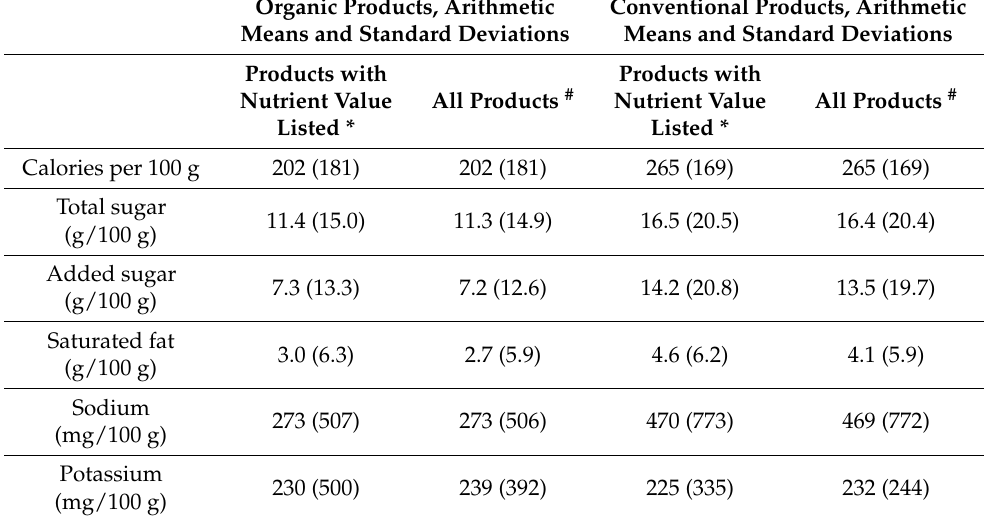
Table A1. Nutritional characteristics for organic and conventional products per 100 g serving for 8240 organic and 72,205 conventional products.